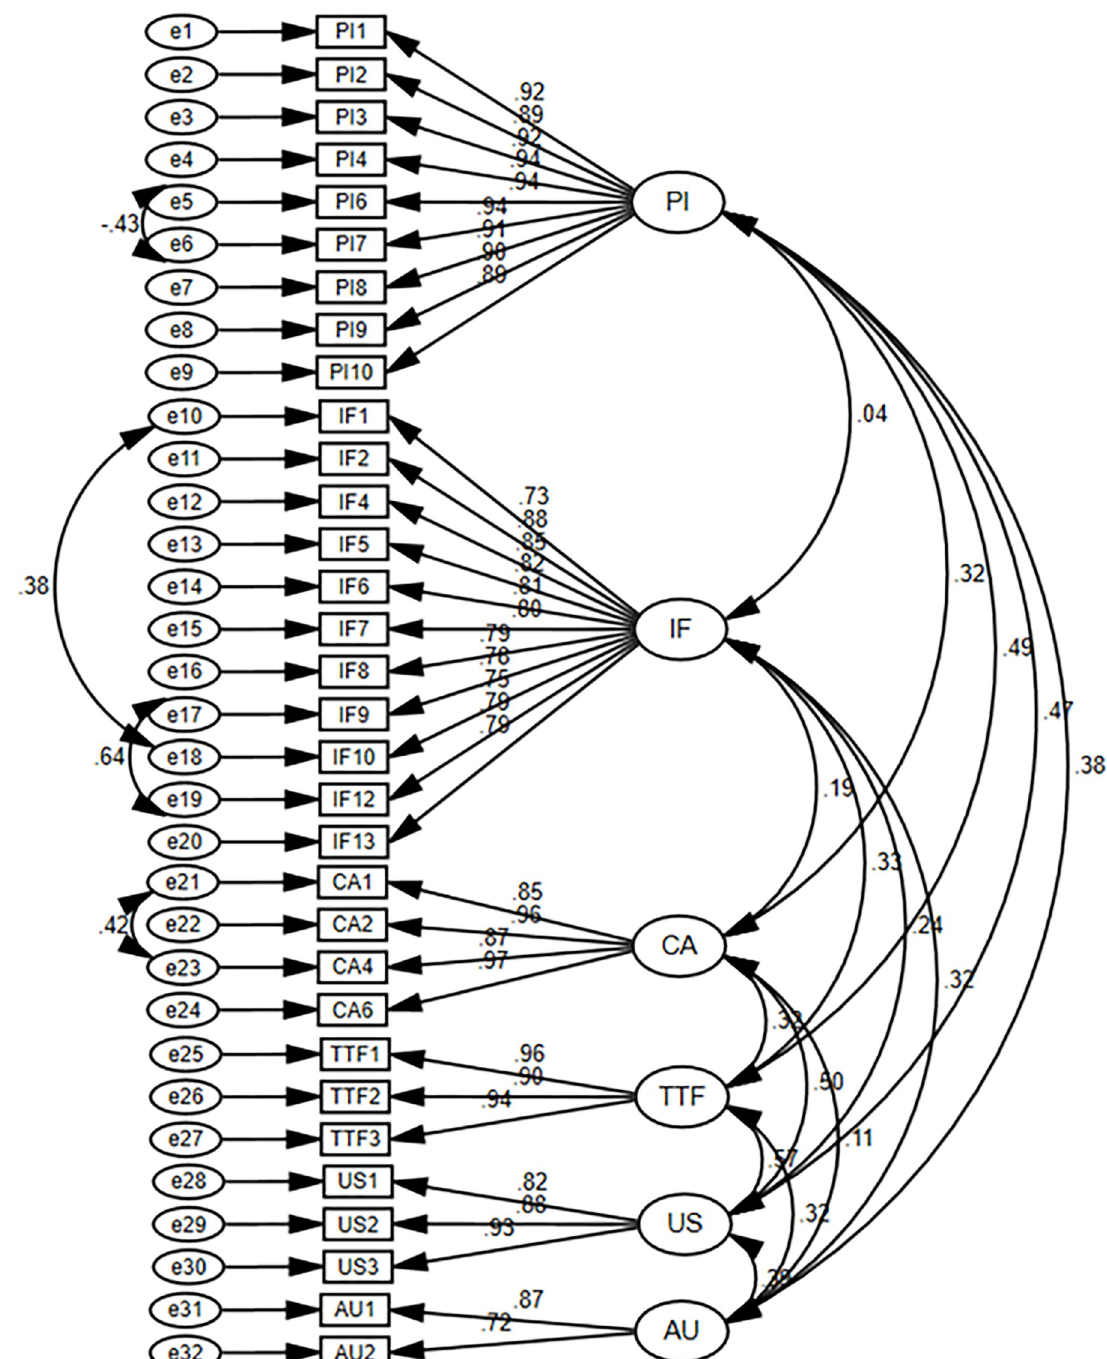
Fig 2. CFA for measurement